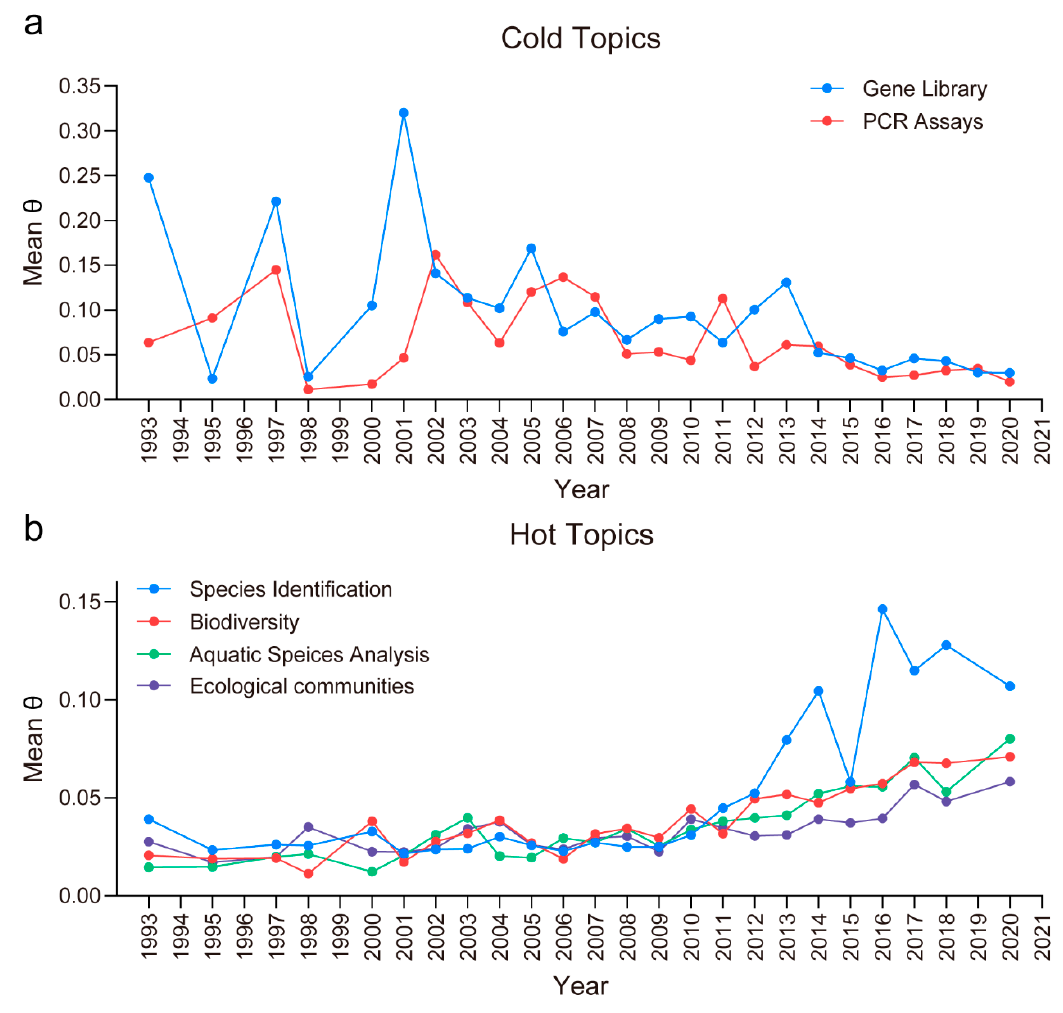
Figure 4. The cold ( a ) and hot ( b ) topics. The significant cold and hot topics sorted by the mean θ (the per-document probabilities for topics). The mean θ by year reflect the increasing and decreasing trends of scientific interests. In this study, we present a basic analysis based on a post hoc examination of the estimates of θ produced by the Latent Dirichlet Allocation (LDA) model [36]. To identify topics that were increasing and decreasing in popularity from 1975 to 2020 (2nd March), we conducted a linear trend analysis on θ of each topic by year. According to the mean θ and significance levels ( p < 0.05), topics were identified as “cold” topics and “hot” topics.